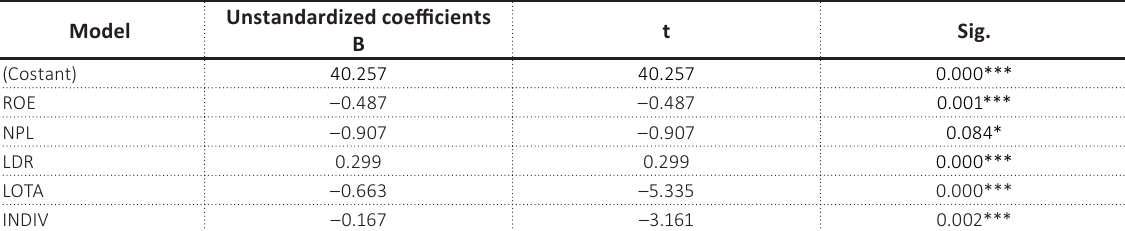
Table 3. Test of regression